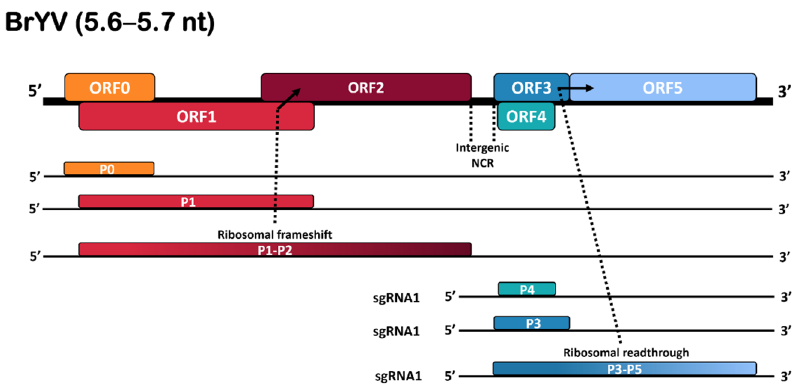
Figure 1. Representation of genomic organisation of BrYV. The ribosomal frameshift and read-through strategies are indicated by arrows; coloured boxes indicate the positions and types of different ORFs and translated proteins.